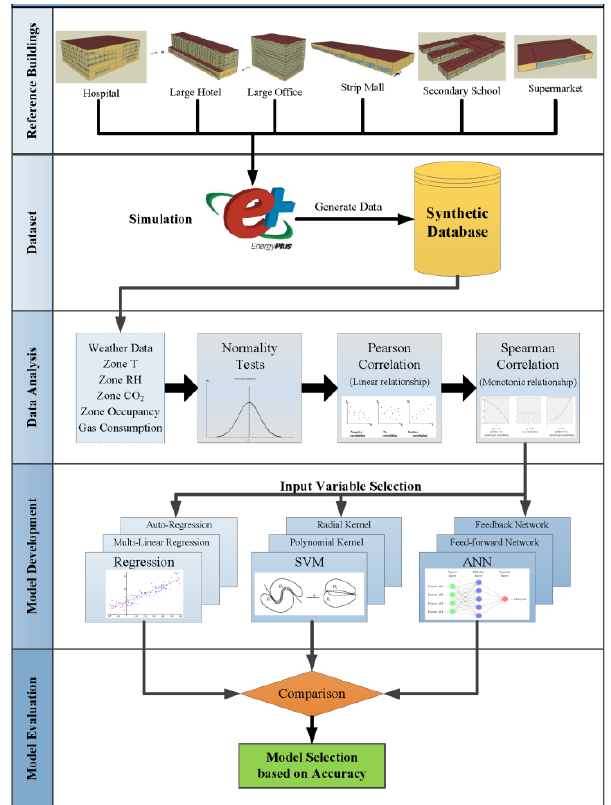
Figure 1. Development of